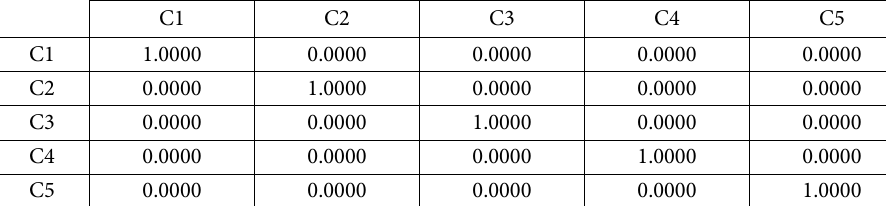
Table 9. Identity matrix I for inter-cluster relationships